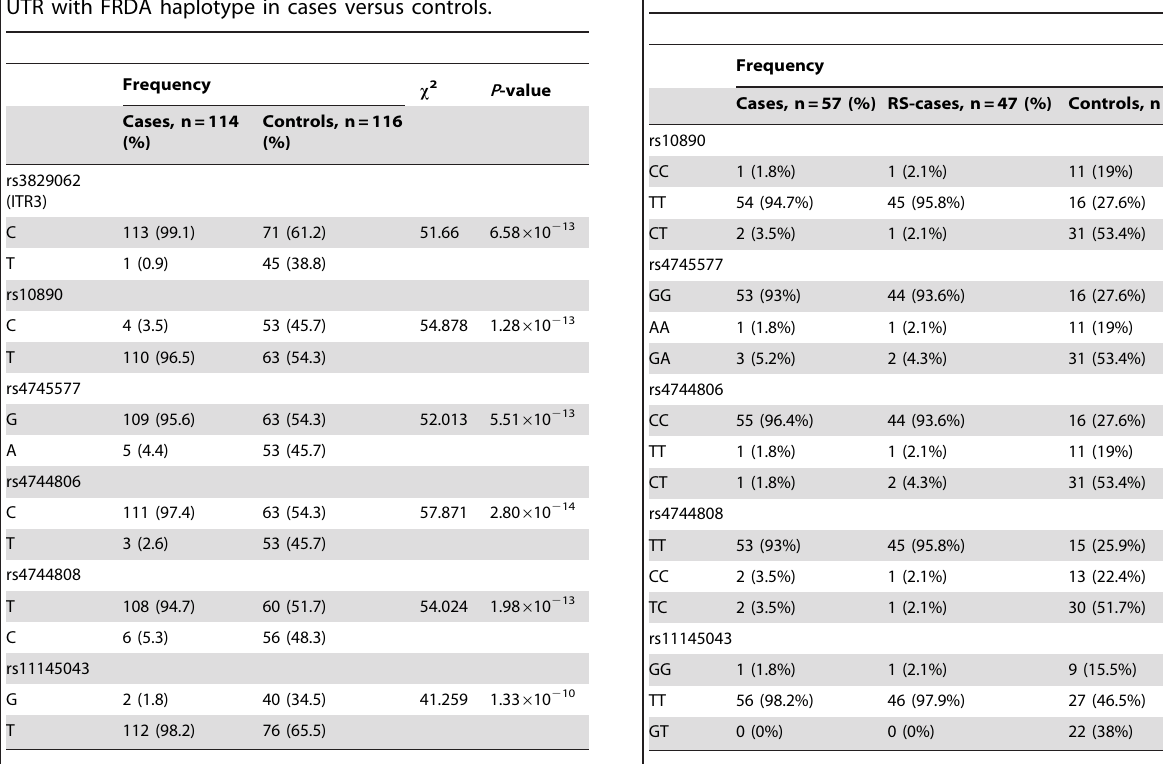
Table 2. Genotype frequencies of the five SNPs for the FXN 3 9 -UTR in cases, cases from the replication study (RS-cases), and